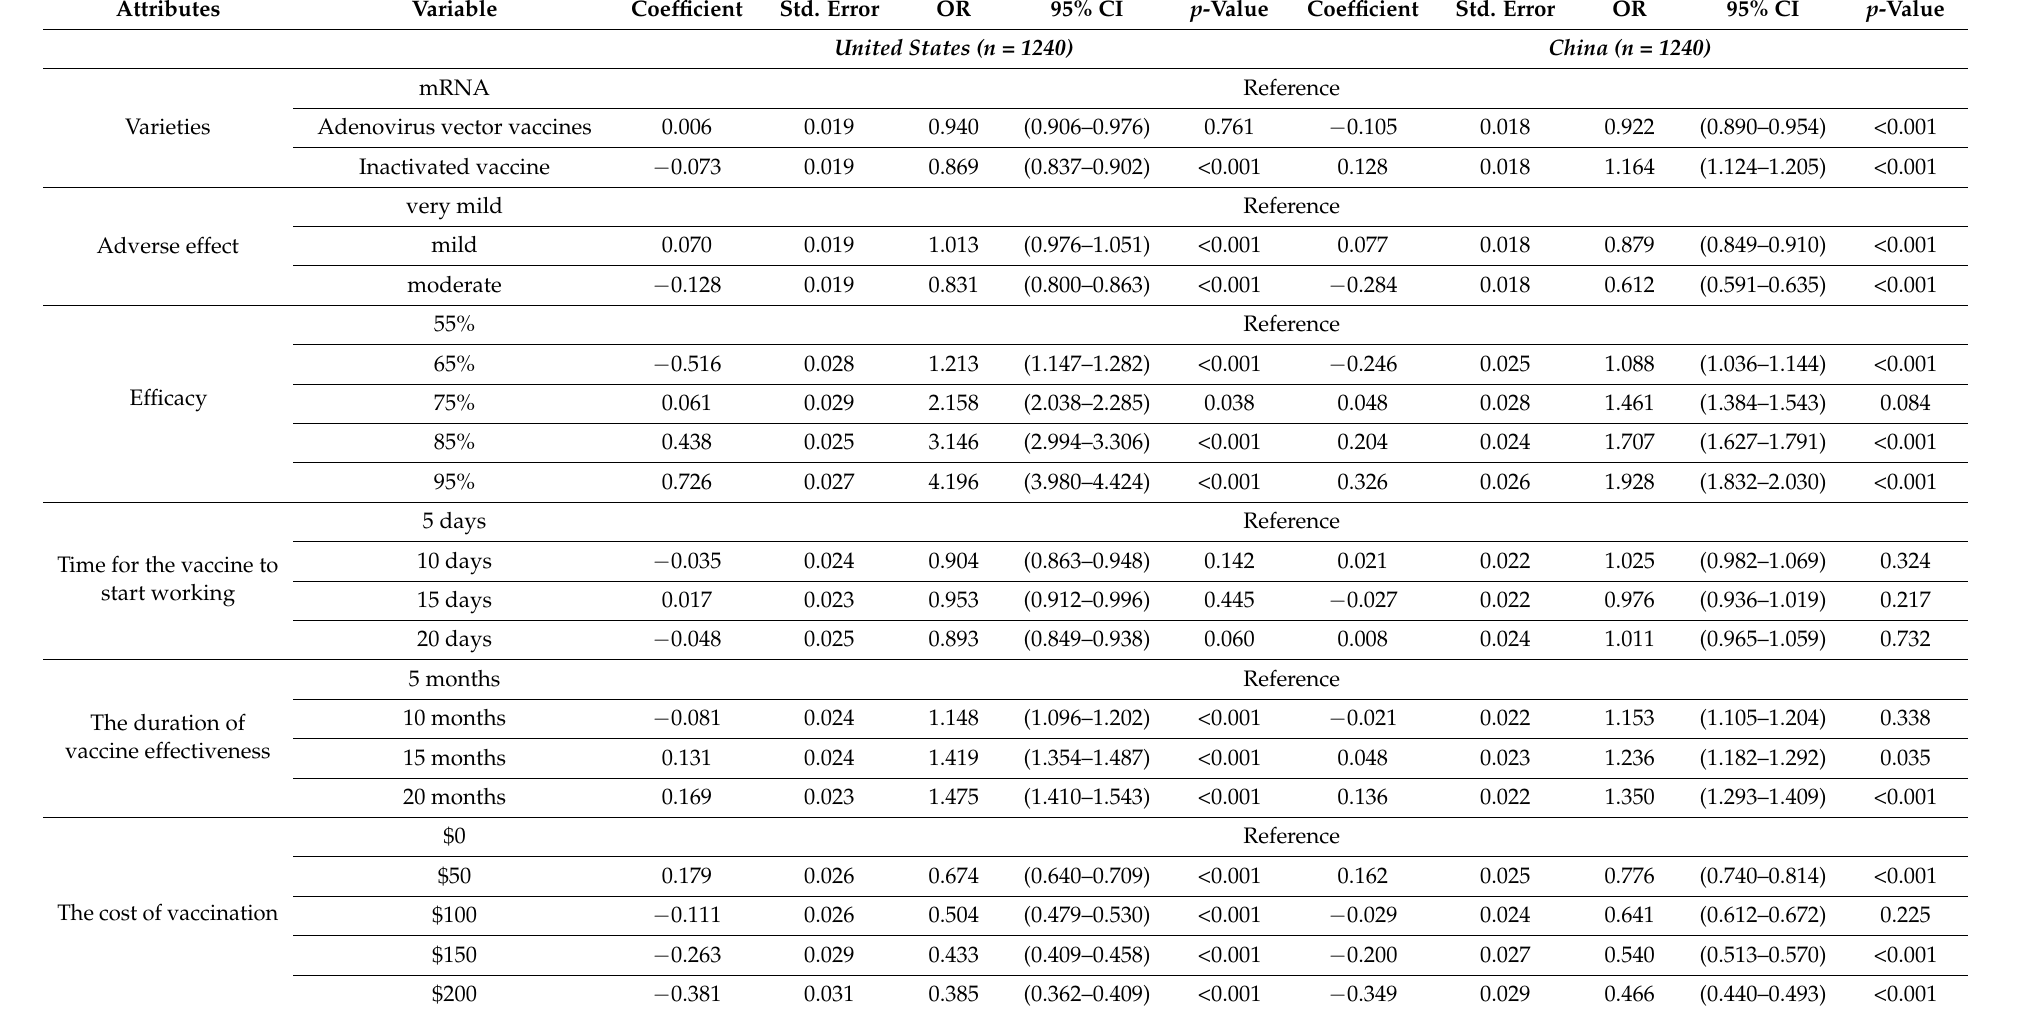
Table 3. Comparison between the United States and China in attributes levels utility and odds